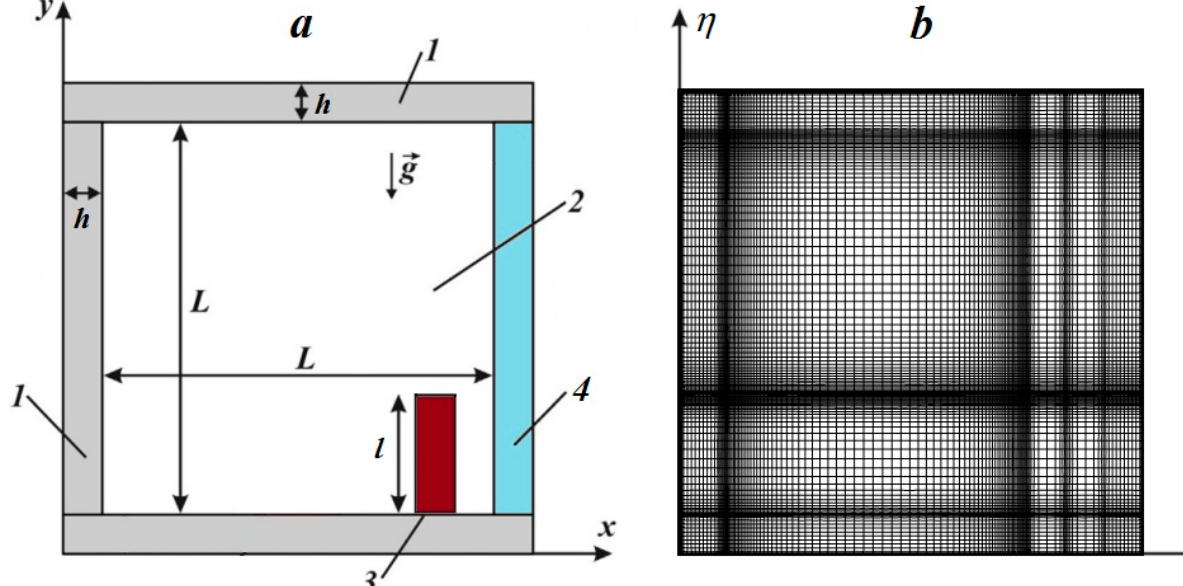
Figure 2. Computational domain ( a ) and utilized mesh ( b ): 1—massive walls, 2—air, 3—thermally-generating source; 4—glass